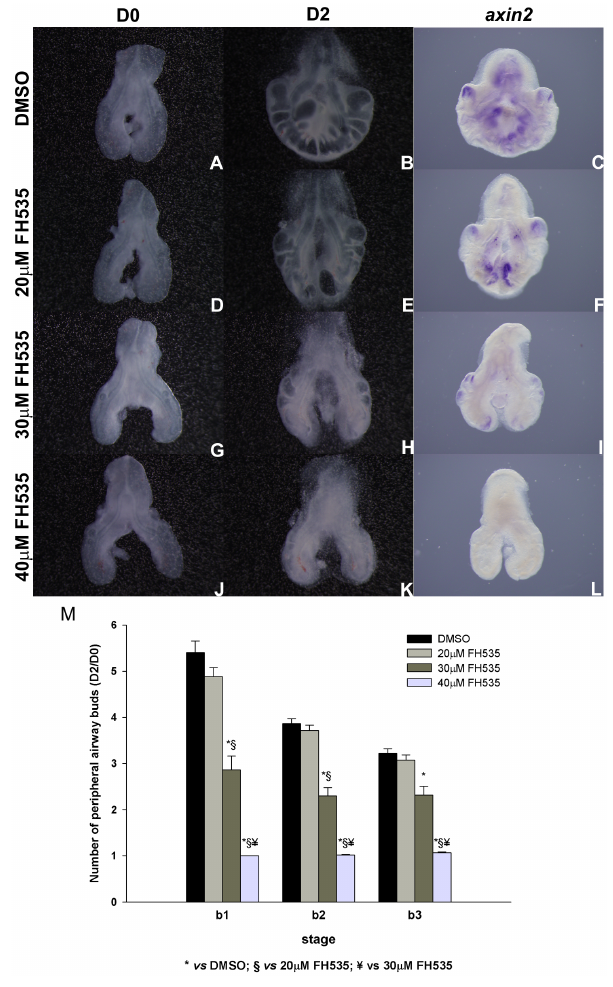
Figure 6. In vitro Wnt signaling inhibition (FH535) and branching analysis of lung explants. Representative examples of stage b2 lung explant culture, at D0:0h ( A, D, G, J ) and D2:48h ( B, E, H, K ) treated with DMSO (A, B), 20 m M (D, E), 30 m M (G, H) and 40 m M FH535 (J, K) and probed with axin2 ( C, F, I, L ); n 5 5 for each stage. Magnification: A, B, D, E, G, H, J, K –4x; C, F, I, L –5x. M : Branching analysis of stage b1 (n > 15 for each condition), b2 (n > 40 for each condition) and b3 (n > 30 for each condition) explants treated with DMSO and FH535 (20, 30 and 40 m M). Results are expressed as D2/D0 ratio. Data is represented